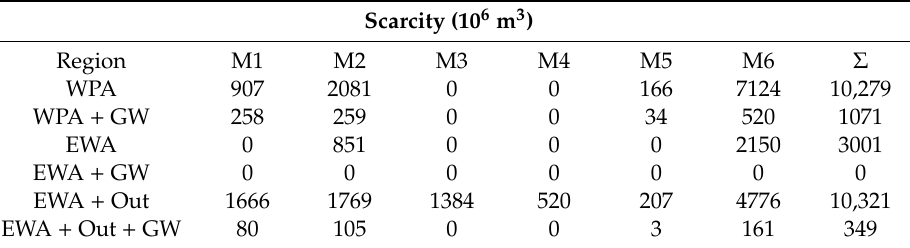
Table 3. Accumulated water scarcity (10 6 m 3 ) in each region for the simulated scenarios.